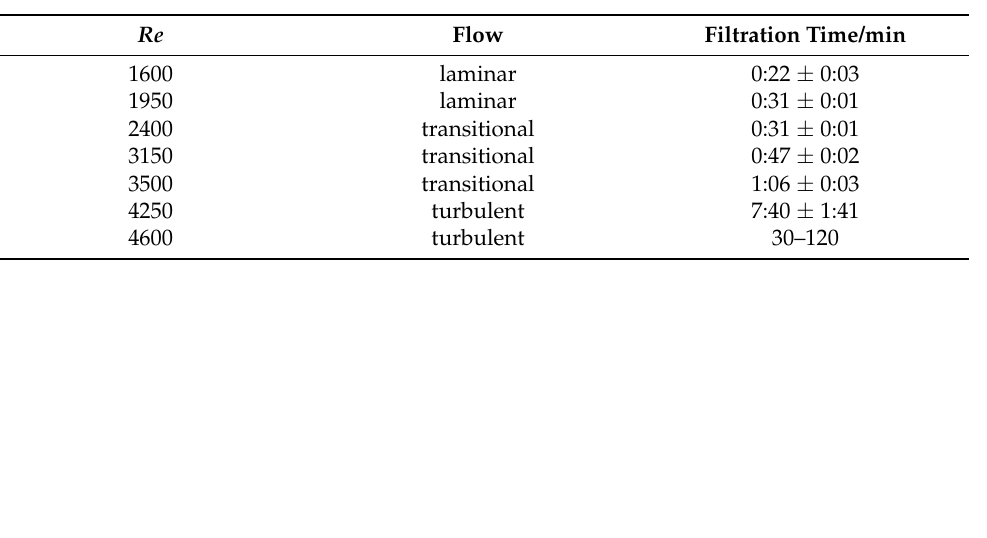
Figure 4. Microscopic images of the textile microstructure for all studied Re . (Olympus LEXT OLS5000 3D Measuring Laser Microscope, MPlanApo N 100 x/0.95 LEXT; Olympus, Tokyo, Japan). Table 2. Average filtration times obtained for the individual Re